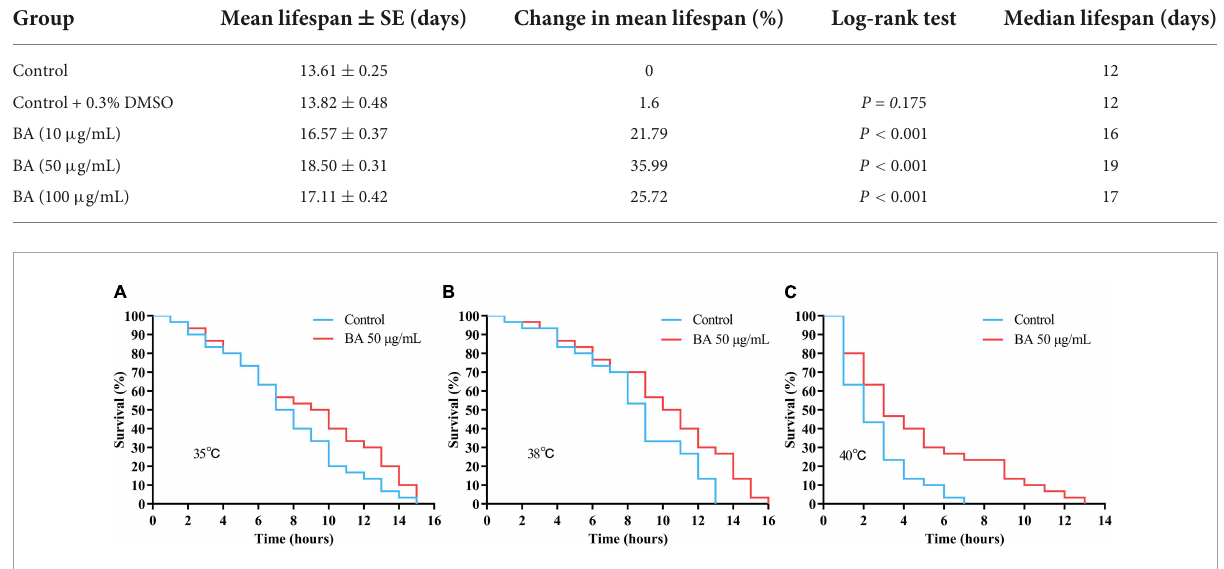
TABLE 3 Effects of betulinic acid (BA) on heat stress resistance in Caenorhabditis elegans. Temperature